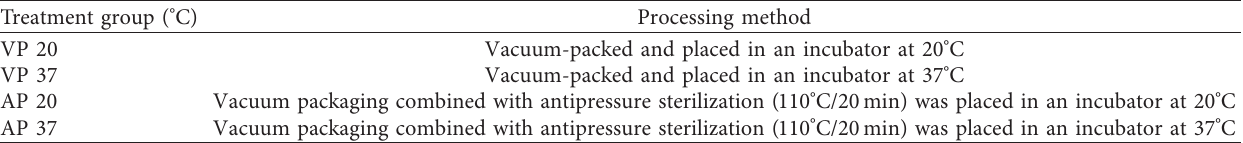
Table 1: Experimental design of the change rule of main physicochemical indexes of dried Penaeus vannamei during storage. Treatment group ( ° C) Processing